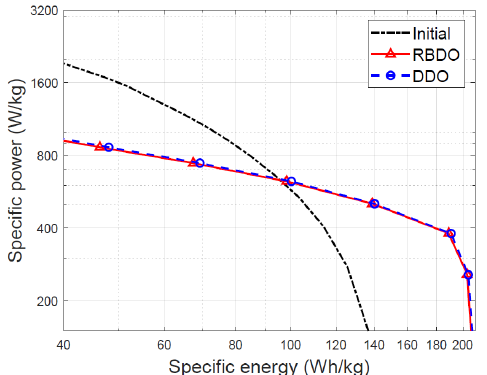
Figure 12. The Ragone plot comparing the initial design with the designs optimized through reliability-based design optimization (RBDO) and deterministic design optimization (DDO) methods.